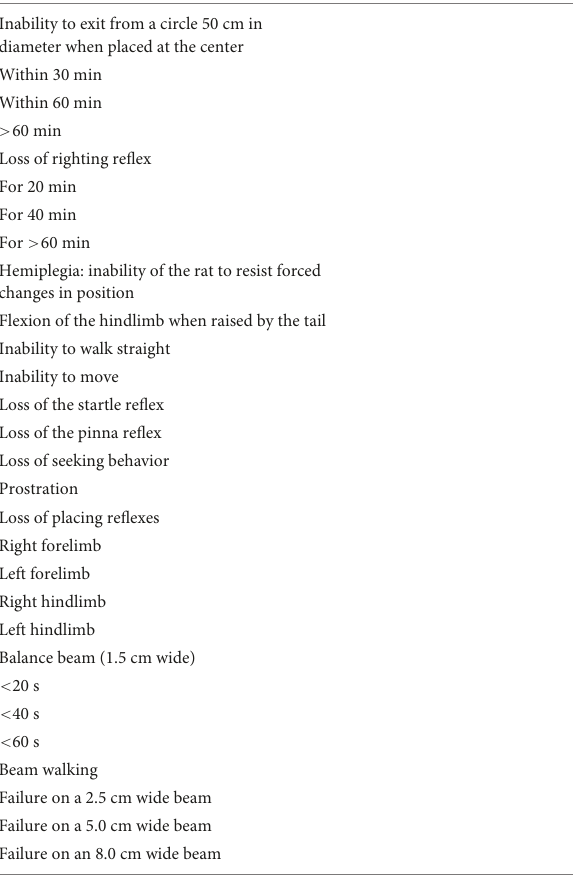
Score (If unable, score 1; If able, score